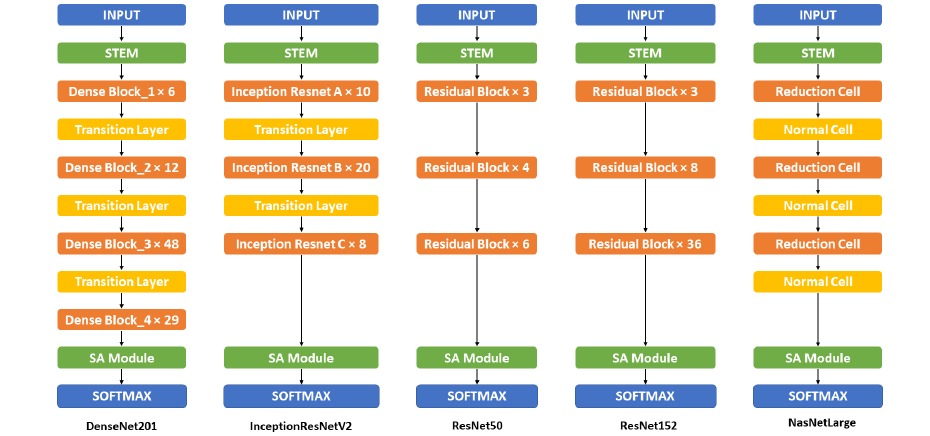
Figure 3. Proposed backbone model architecture. This figure show the overall structure of the backbone model (non mobile-based model) including DenseNet201, InceptionResNetV2, ResNet50, ResNet152, and NasNetLarge with Soft-Attention. The detailed structure and information can be found in the Table A1 in Appendix